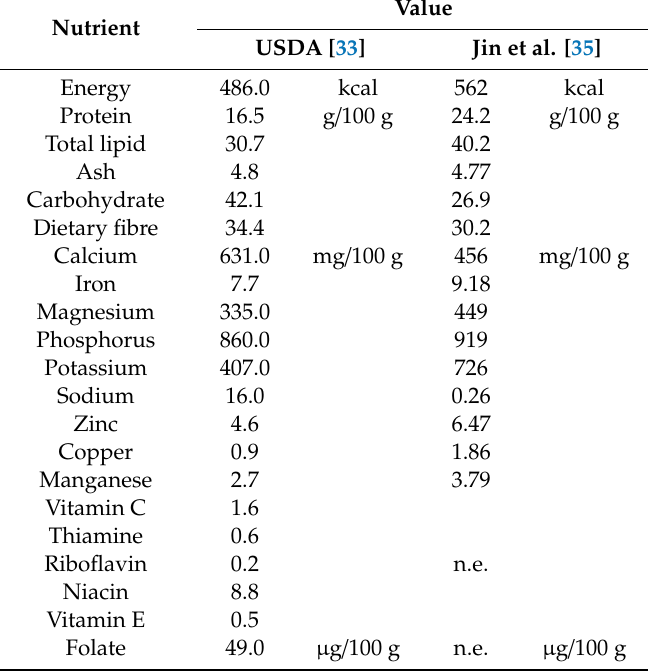
Figure 1. Basic composition of chia seeds [33]. Table 1. Nutritional value of chia seeds.